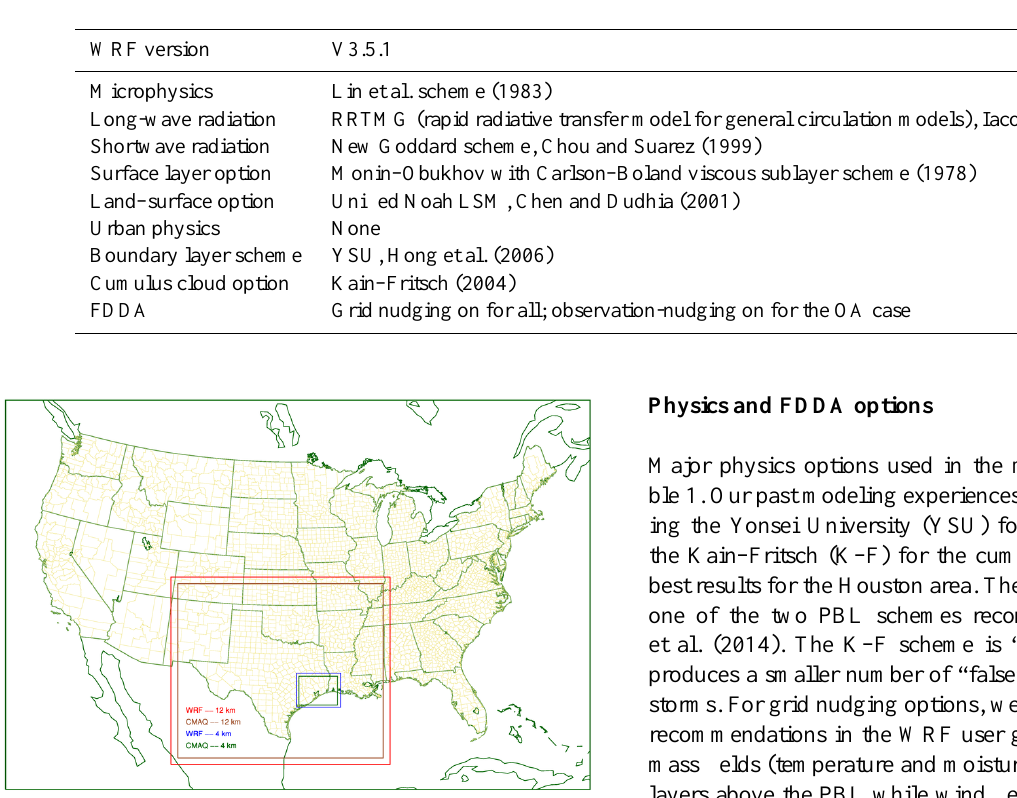
Table 1. Major WRF physics and FDDA options; the numbers in the parentheses are the related settings in WRF namelist file.